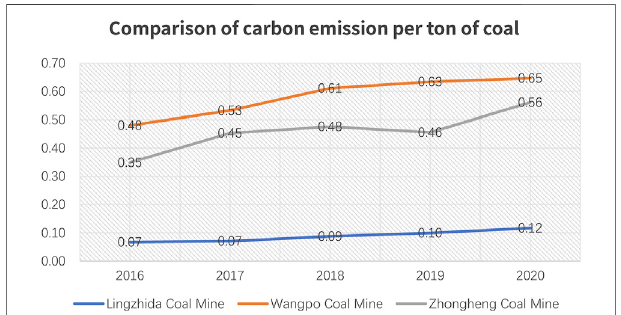
FIGURE 8 | Comparison of carbon emission per ton of